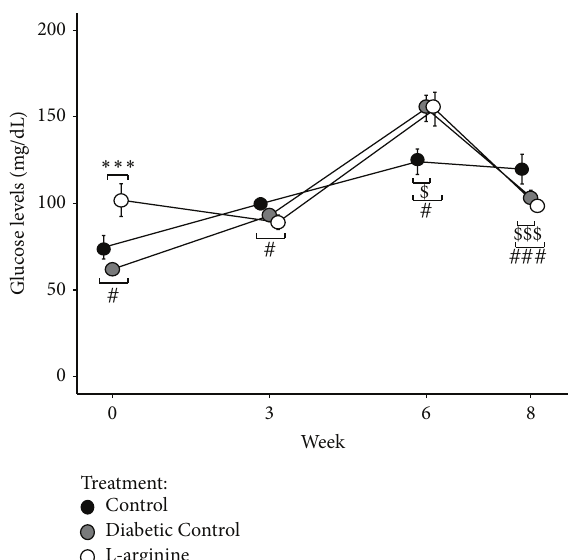
Figure 3: Effect of the high fructose diet alone and high fructose plus L-arginine diet on fasting glucose levels over 8 weeks. Control versus Diabetic Control: $ 𝑃 < 0.05 and $$$ 𝑃 < 0.001 ; Control versus L-arginine: # 𝑃 < 0.05 and ### 𝑃 < 0.001 ; Diabetic Control versus L- arginine: ∗∗∗ 𝑃 < 0.001 .